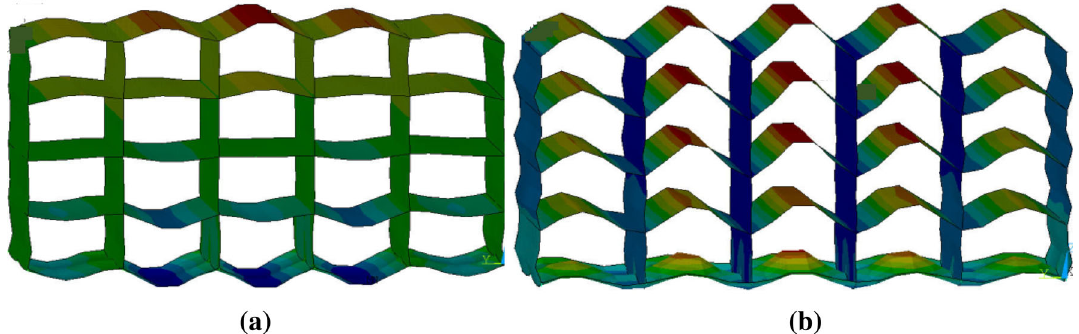
Fig. 10 Vibration modes of the apartment building at a 24 Hz and b 37